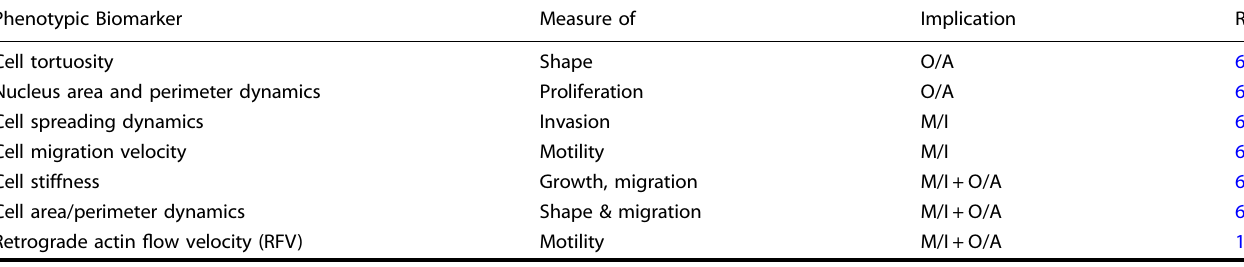
Table 1. List of live cell phenotypic biomarkers and their implication in tumorigenesis Phenotypic